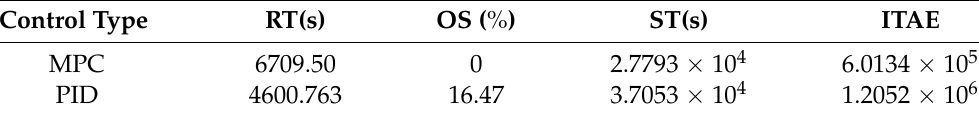
Table 5. Step 1 performance indicators.